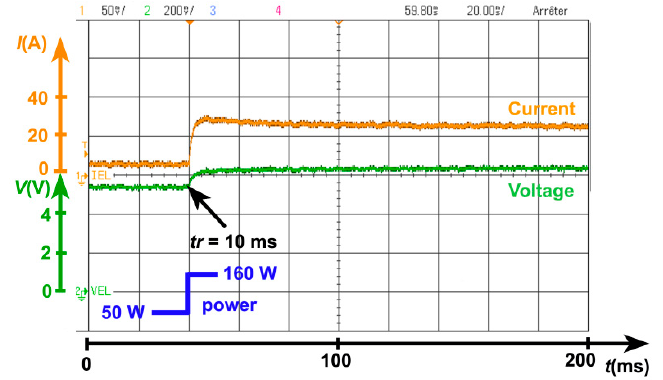
Figure 16. Voltage and current at the terminals of the electrolyzer.